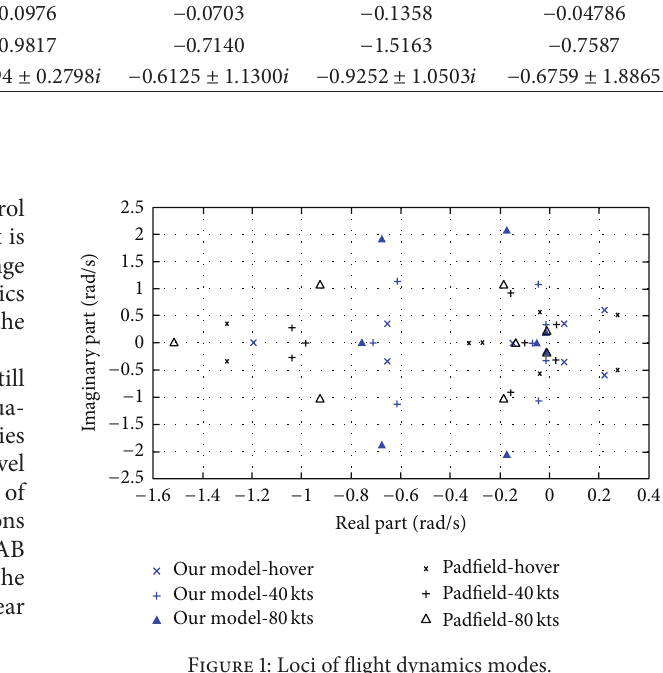
Figure 1: Loci of flight dynamics